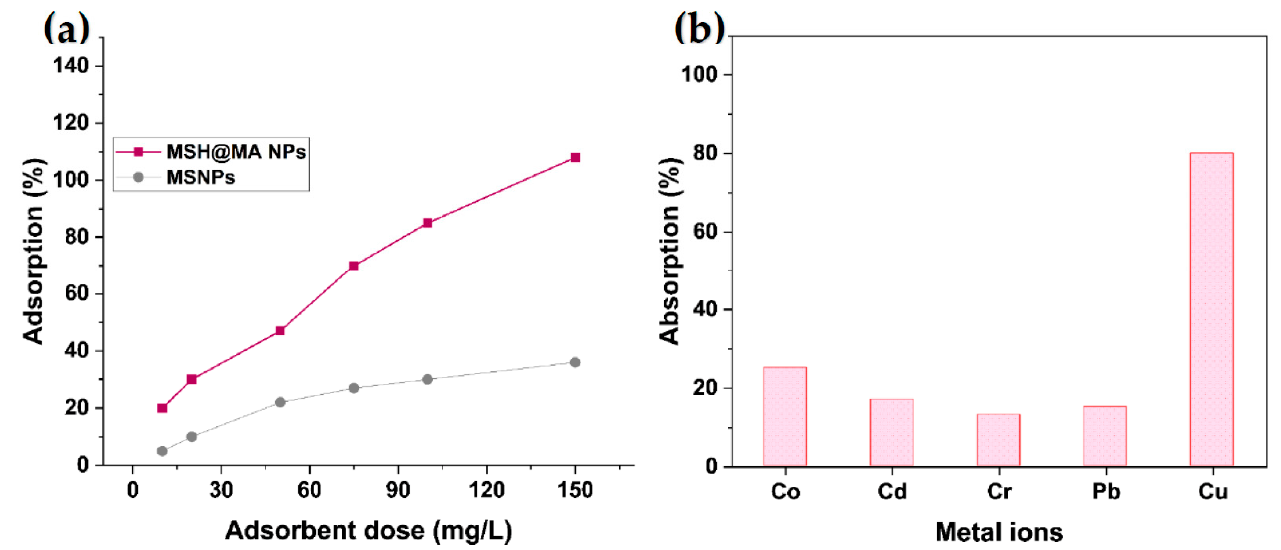
Figure 6. ( a ) Effect of adsorbent dosage of Cu 2+ ions onto the MSH@MA and MS NPs. ( b ) Selective adsorption efficiency for various competitive metal ions by MSH@MA NPs.